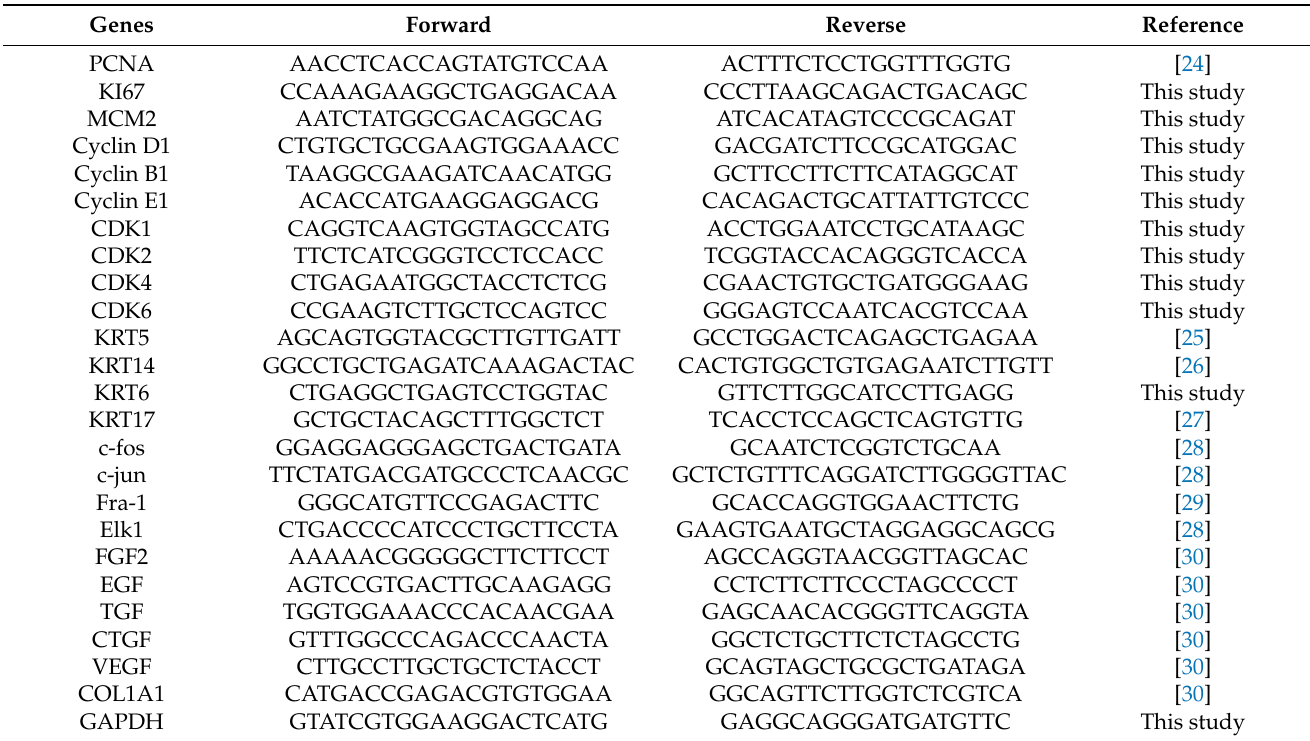
Table 1. Primers used in this